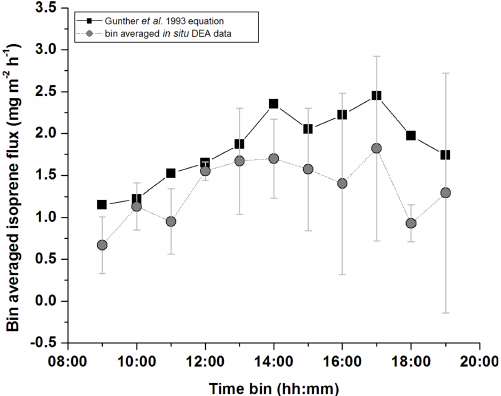
Fig. 6. Comparison of average isoprene flux measured by DEA dur- ing CABINEX 2009 to emission algorithms described by Guenther et al. (1993). The emission algorithm overpredicts measured iso- prene fluxes but is generally within the 1 σ standard deviation of the isoprene flux as